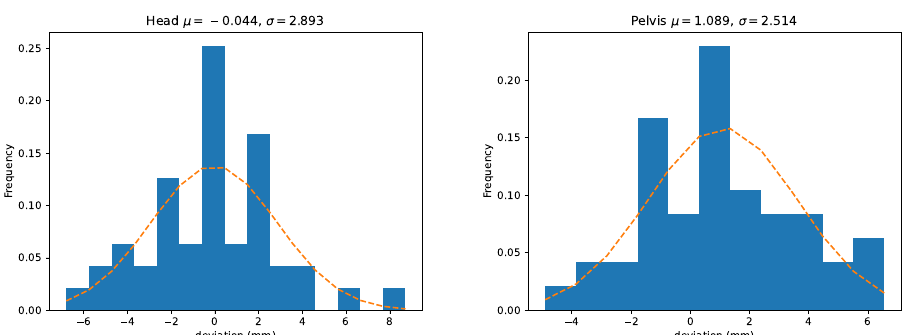
Figure 11. Distributions of the per-trial deviations for head ( left ) and pelvis ( right ). Here we have combined both peak and valley deviations defined in Section 2.7.1 ( ∆ ¯ V and ∆ ¯ P ). The dashed line shows the normal distribution estimated from the means and standard deviations of the